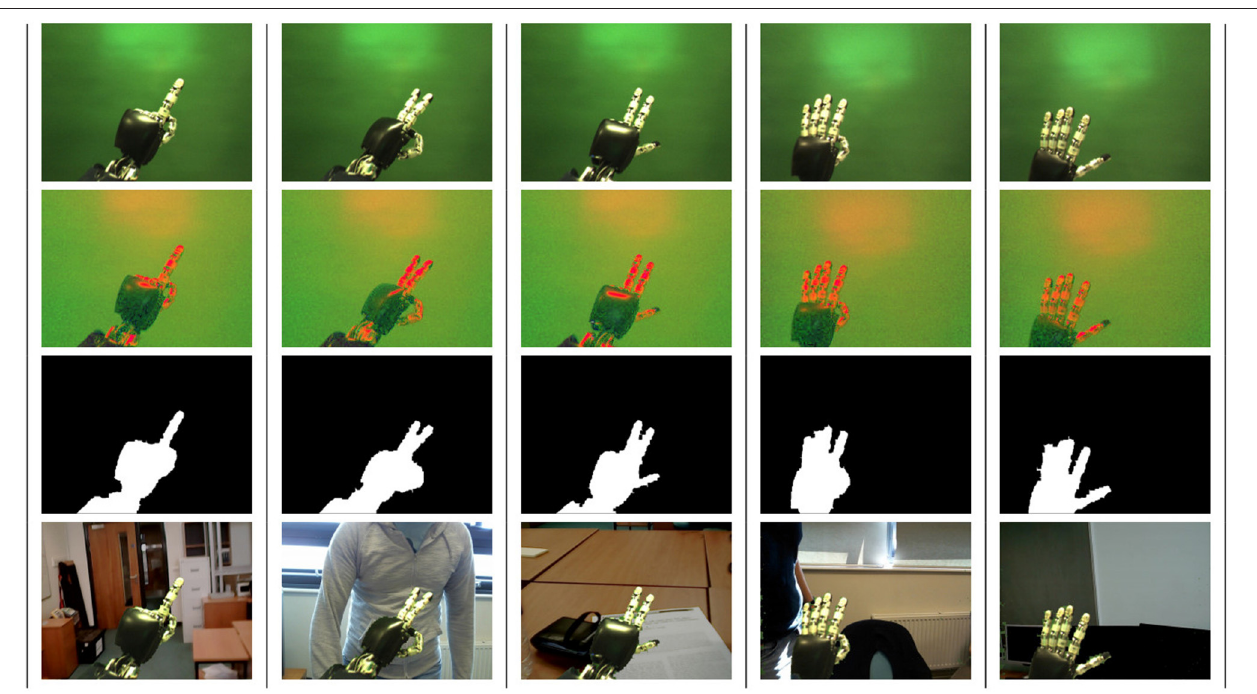
FIGURE 2 | A sample of the iCub robot hand images from the dataset, with columns representing numbers from 1 to 5. Each row represents one or more stages from the previous list: the first row contains original images; the second row shows the images converted from RGB to HSV; the third row shows the mask for noise removal; finally, the fourth row shows the extracted hand region applied to a different background.